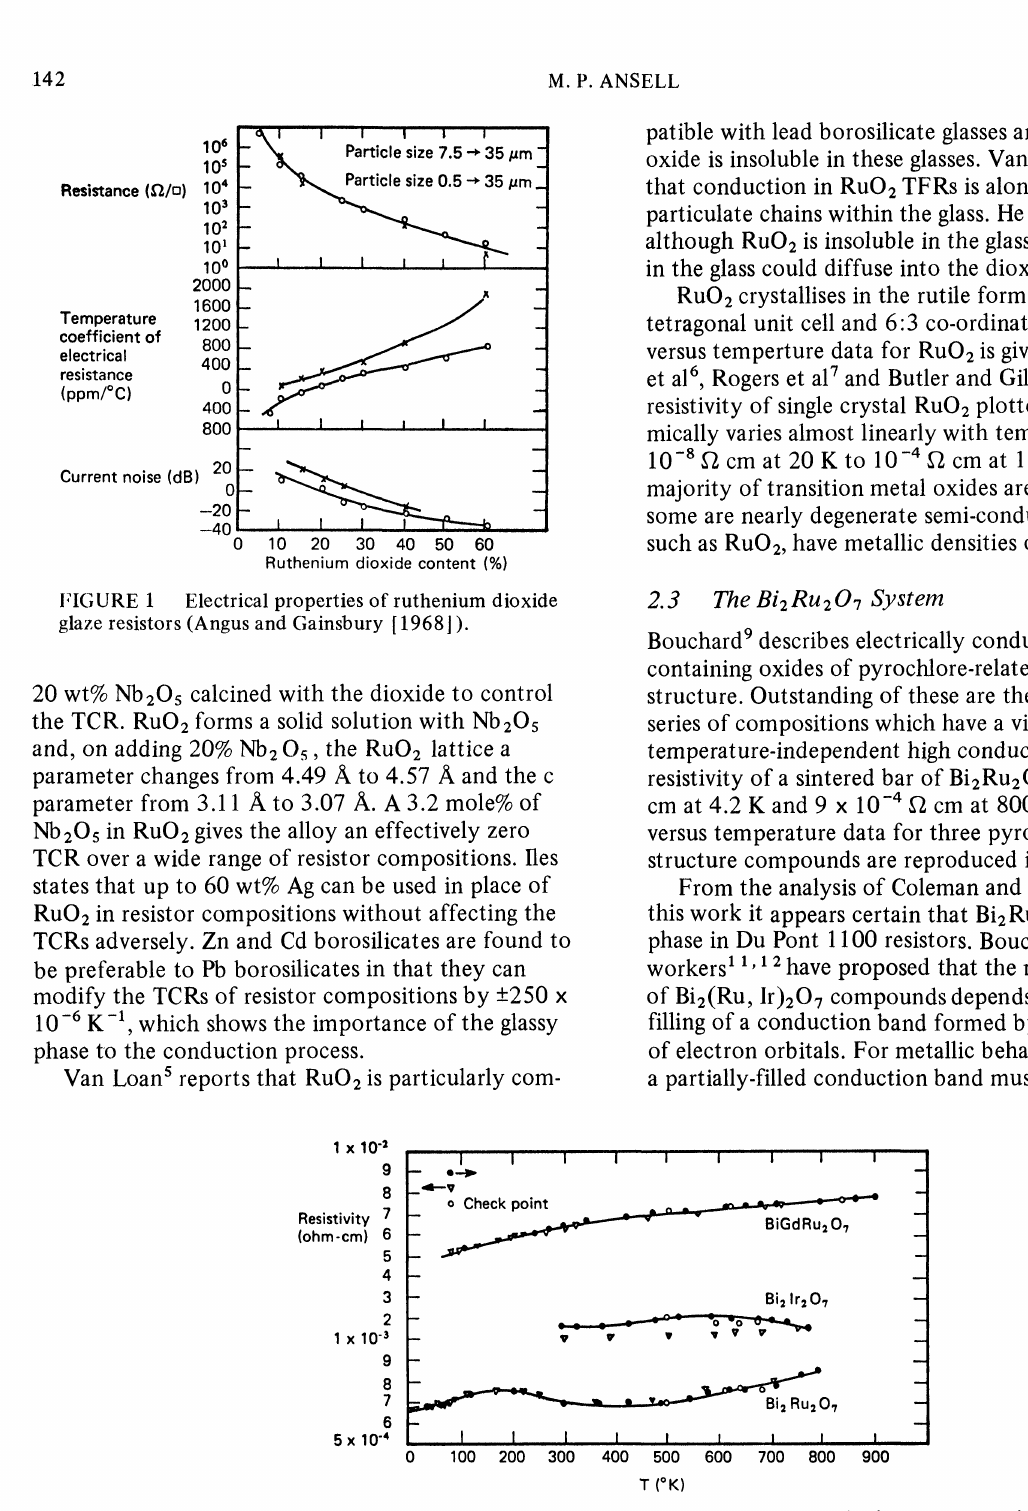
FIGURE 2 Resistivity versus temperature for three polycrystalline pyrochlores. Check points are made by cooling from some slightly higher temperature to assure that decomposition has not taken place. (Bouchard and Gillson